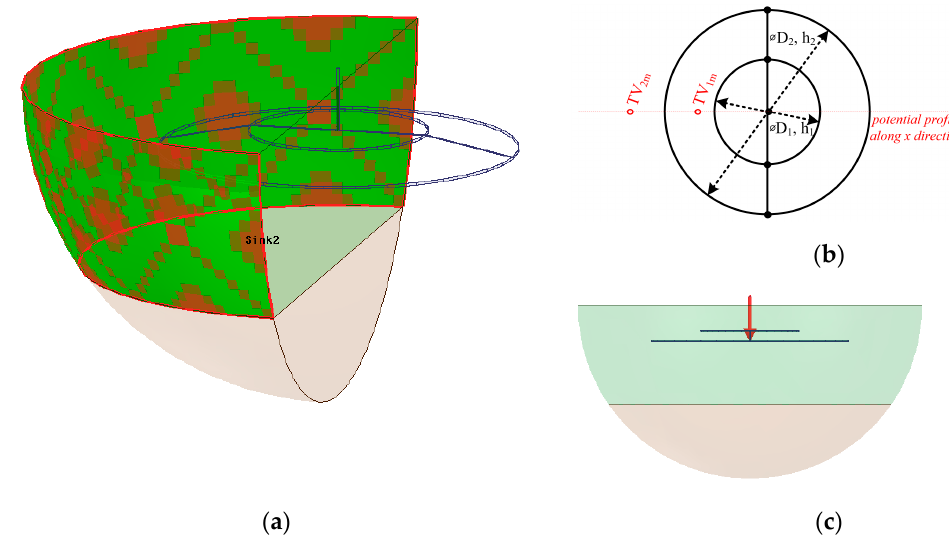
Figure 1. Earthing system model, spatial view ( a ), top view ( b ), and side view ( c ). Table 1. Sensitivity analysis soil models.